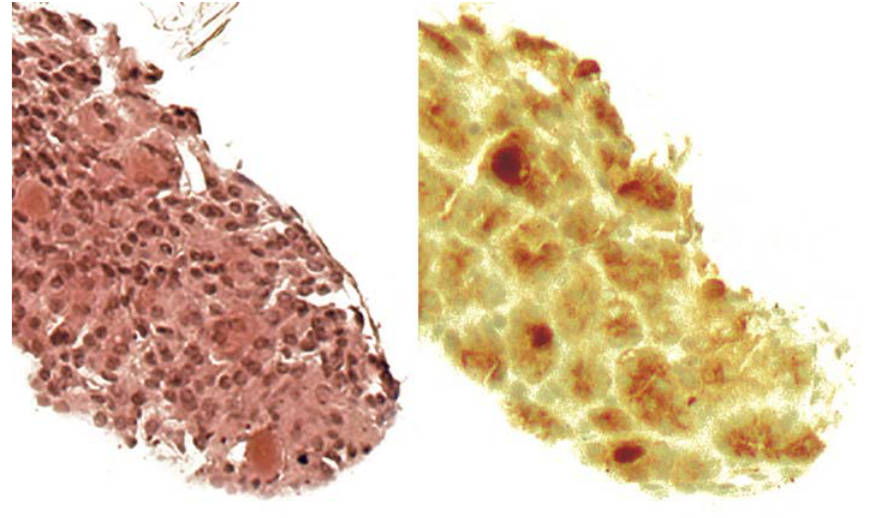
Fig. 2 Fine needle biopsy of the parathyroid gland. Left: hematoxylin and eosin staining. Right: immunohistochemical marking of parathyroid hormone (brown colour).